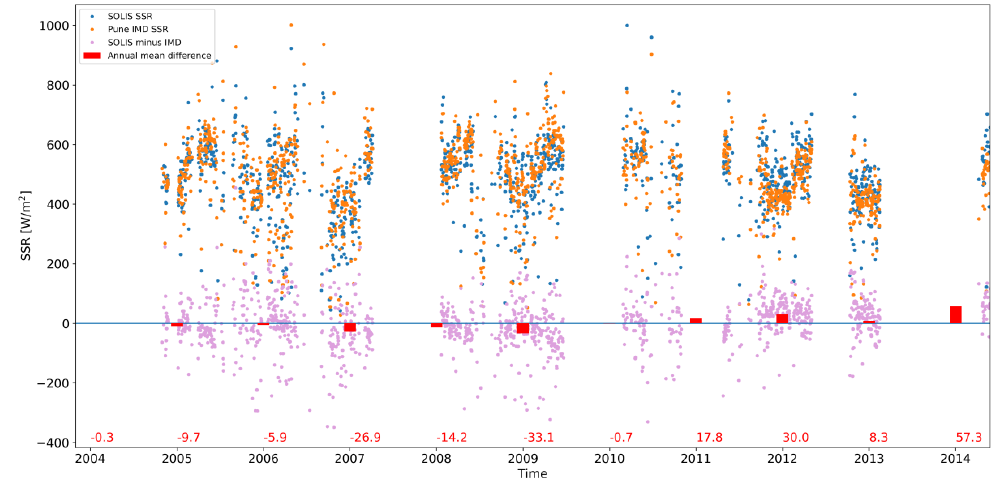
Figure 8. Comparison of daily mean SSR calculated from Simplified Solis with AERONET atmospheric inputs, and in situ measured SSR at Pune. Red bars and numbers at the bottom show their annual mean difference.